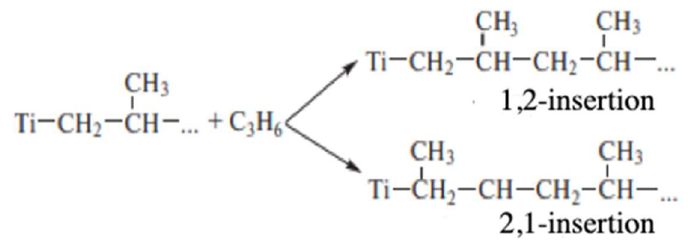
Figure 1. Reaction of propylene on a titanium-magnesium catalyst.